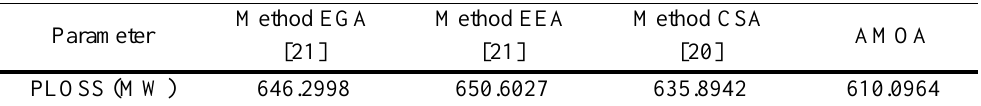
Table 12. Comparison of real power